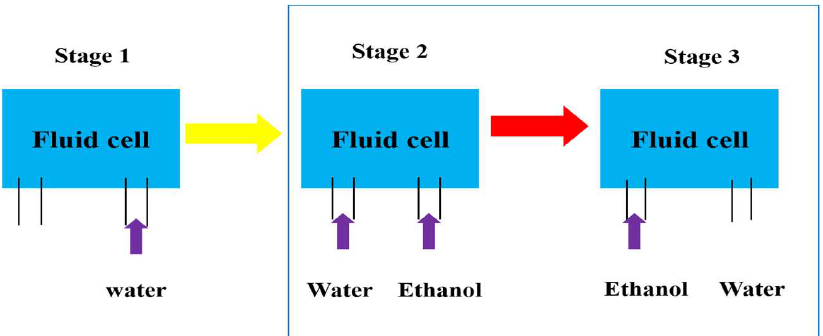
Figure 4. A stepwise process of alcohol–water exchange method and generation of ultrafine bubbles. Reprinted with permission from [68]. Copyright (2015) by the American Physical Society.